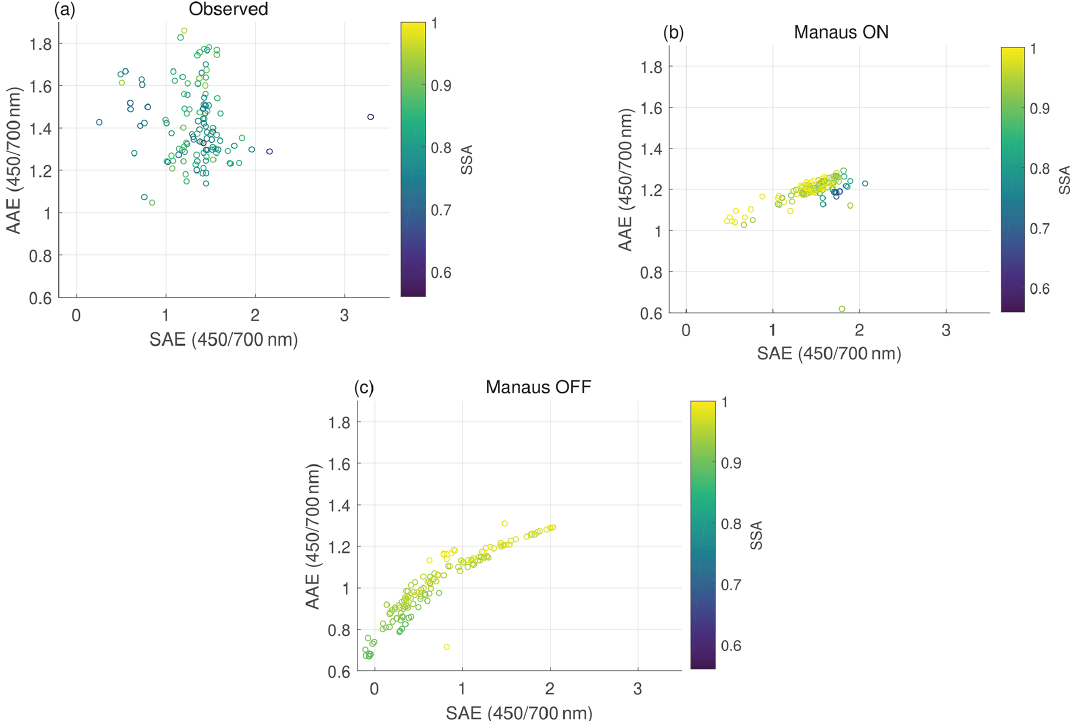
Figure 8. Absorption Ångström exponents (AAEs) at the wavelength pair 470 and 660nm, as a function of the corresponding scattering Ångström exponents (SAEs) at the wavelength pair 470 and 660nm, which are color coded using the related SSA at the wavelength pair 470 and 660nm. The 1h averaged instantaneous observed data values (a) from simultaneous nephelometer and aethalometer measurements from 9 to 14 March 2014 at the T3 site. (b) The 1h averaged simulated values when all emissions are on. (c) The 1h average simulated values when just biogenic emissions are on and anthropogenic emissions are